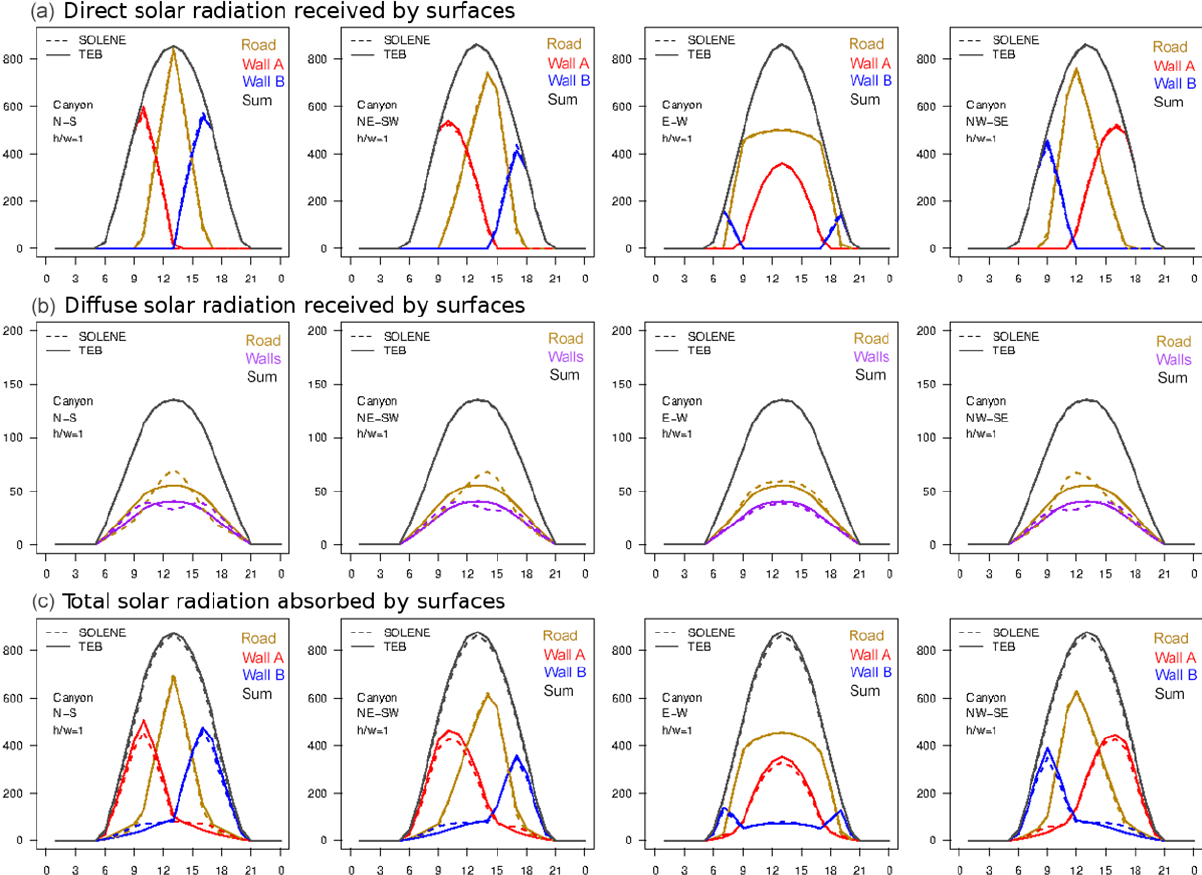
Figure 4. Comparison of TEB and SOLENE simulations of hourly direct (top) and diffuse (middle) solar radiation fluxes (Wm − 2 ) received by urban facets before multiple reflections, and total shortwave radiation fluxes (Wm − 2 ) absorbed by urban facets after inter-reflections (bottom) for urban canyons without vegetation. The results are presented here only for the aspect ratio equal to 1 and for the four street orientations during a summer